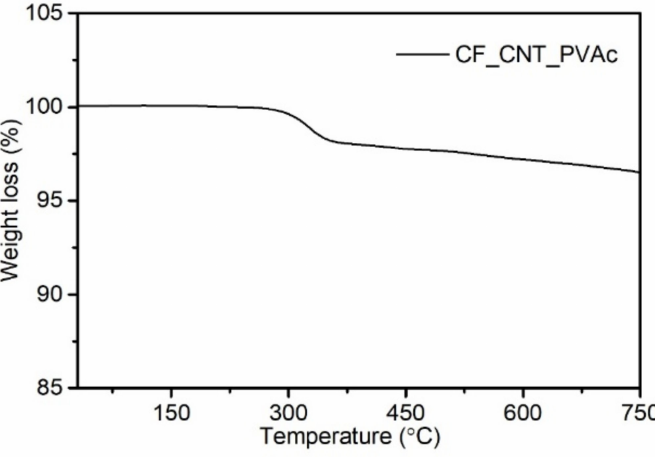
Figure 1. TG plot of carbon hybrid filler